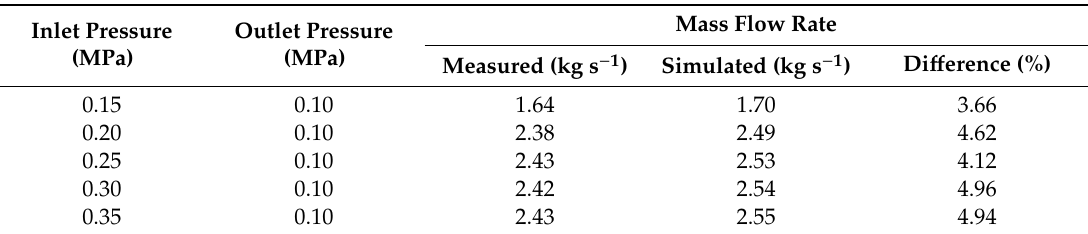
Table 3. Comparison between simulated and experimental values for mass flow rate under different differential pressures.